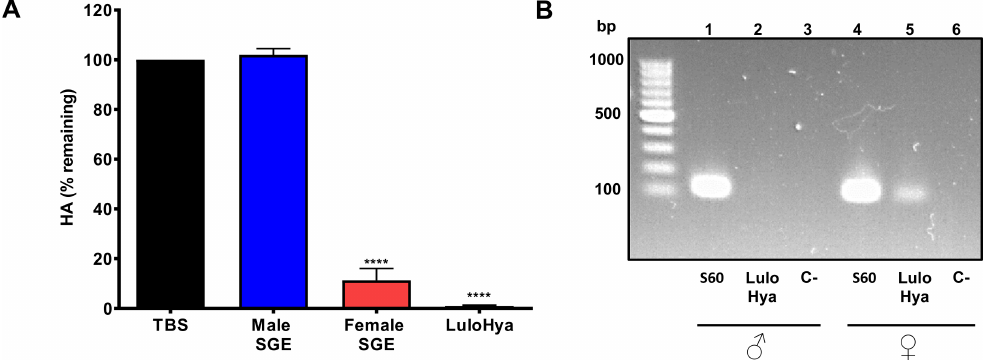
Fig 1. Characterization of LuloHya. Hyaluronidase activity is female specific in Lu . longipalpis .(A) SGE from 10 male Lu . longipalpis did not show any cleavage of HA in the turbidimetric assay, expressed as the % of remaining HA. On the contrary, SGE from 1 female and 10 nM recombinant LuloHya exhibited remarkable hyaluronidase activity. Multiple comparisons were done by one-way ANOVA ( (cid:3)(cid:3)(cid:3)(cid:3) : p < 0.0001). Bars indicate the standard error of the mean (SEM). (B) Gene coding LuloHya is specifically expressed in female sand flies (lane 5). Sybr Safe 2% agarose gel electrophoresis of PCR products from RT-PCR of LuloHya gene with cDNA from male and female Lu . longipalpis head and thorax (lanes 2 and 5, respectively). S60 gene was used as the reference gene (lanes 1 and 4). Reaction mixes without DNA were included as negative controls (lanes 3 and 6). GeneRuler 1kb DNA ladder was used (Thermo Scientific).